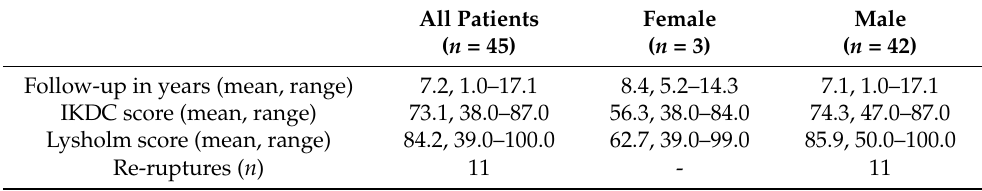
Table 2. Follow-up and patient-reported outcome measure scores.